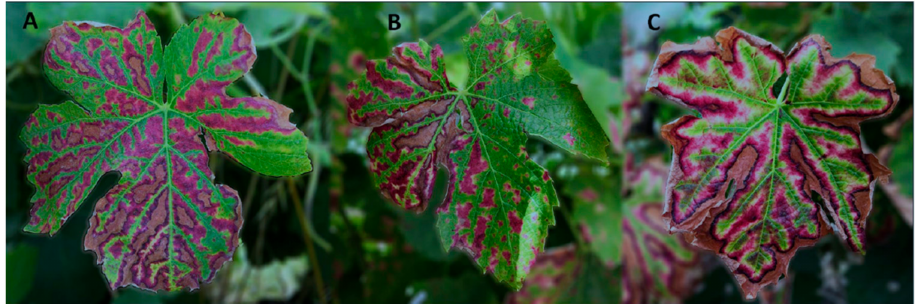
Figure 2. Leaves of Vitis vinifera cv. Touriga Nacional affected by interveinal necrosis (Lisbon, June 2021). Necrotic spots may occur on the whole leaf lamina ( A ) or parts of it ( B ), occasionally involving leaf margins ( C